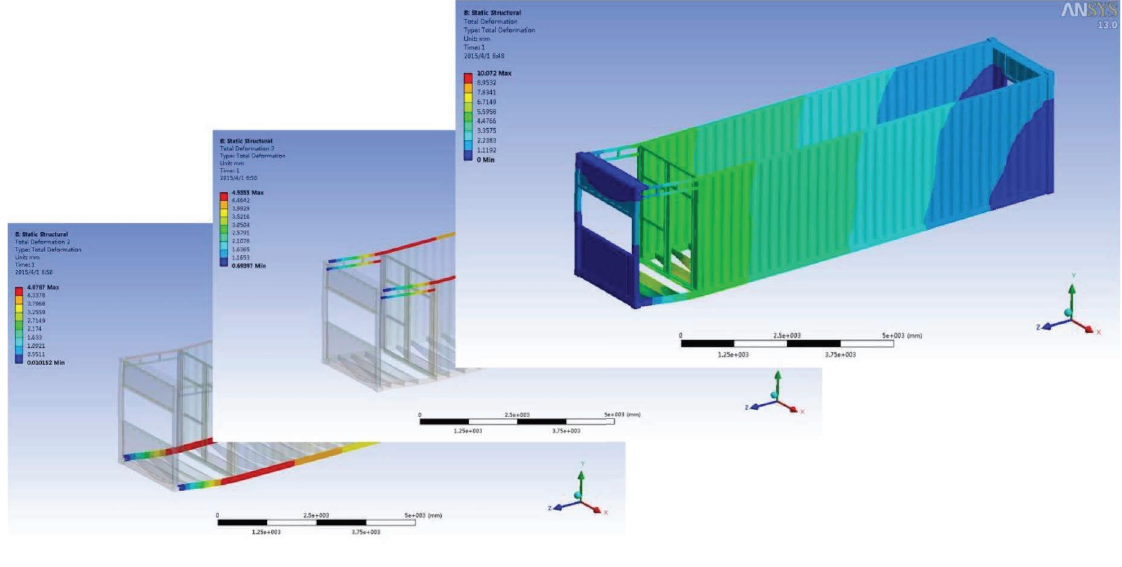
Figure 10: Finite element stress analysis on modules of a container